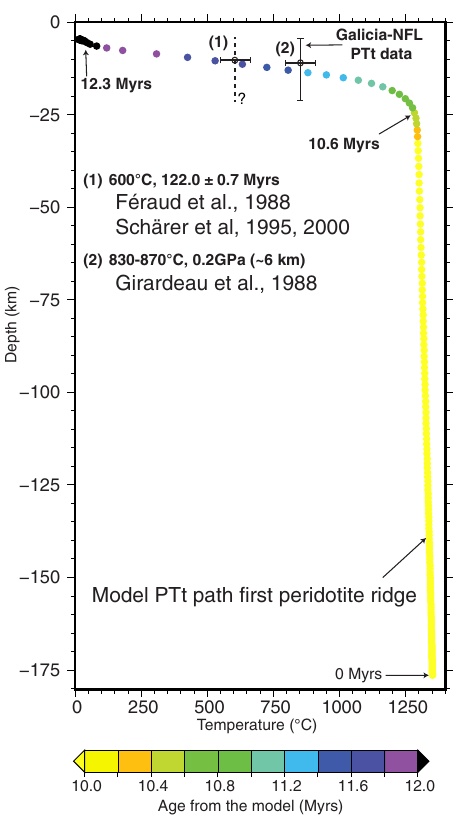
Fig. 5 Pressure-temperature-time (PTt) path of the fi rst peridotite ridge in the numerical model. The mantle exposed on top of the fi rst peridotite ridge in the numerical model (see location in Fig. 4a) is at t = 0 Ma located at 175 km depth. The PTt path follows the adiabatic gradient before the mantle is being cooled down quickly during the last stage of exhumation from 1300 °C at 25 km depth to ~50 °C at 5 km depth in <2 Myr. This PTt path is in agreement with observations made of the exhumed peridotite ridge along the Galician margin sampled by ODP leg 103, hole 637a 29 – 32 . Observed mylonitization during cooling between 1000 and 860 °C, serpentinization during brittle deformation, and low cogenetic partial melting are compatible with the predicted PTt path 29